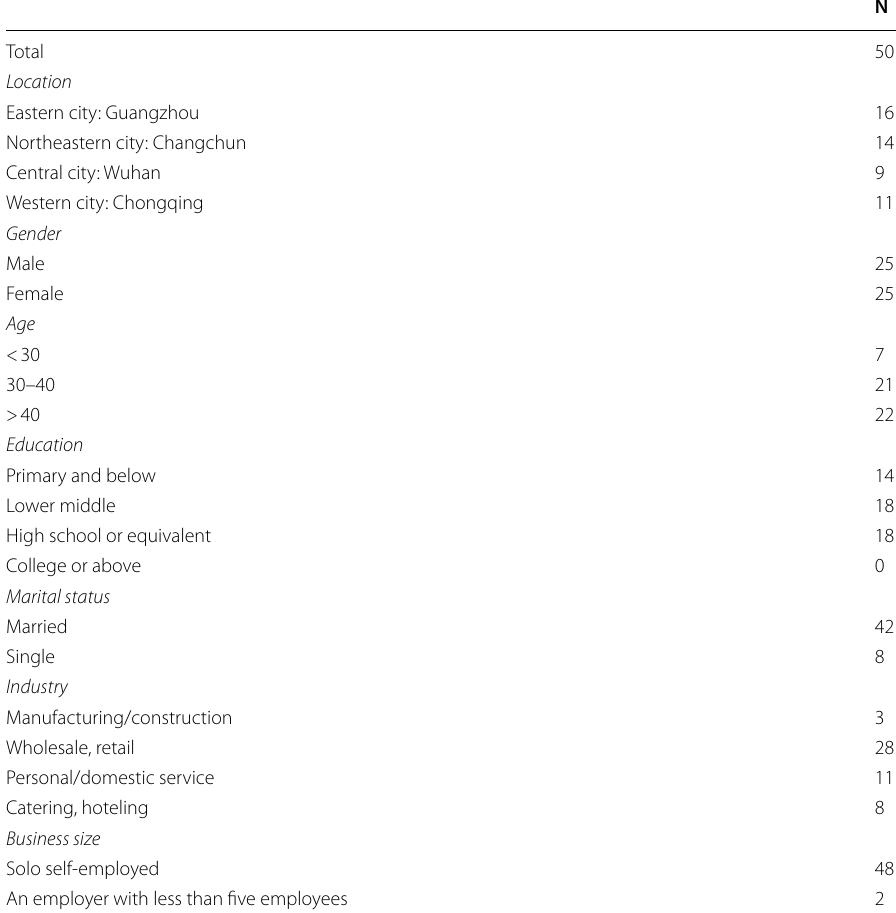
Table 1 Summary characteristics of fieldwork respondents